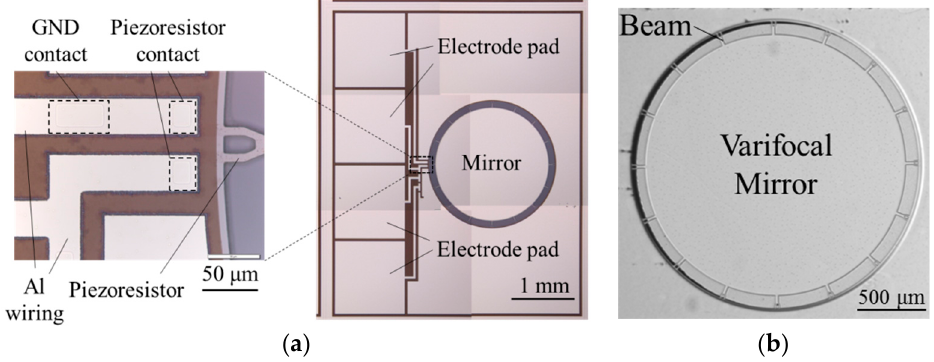
Figure 7. ( a ) Optical micrographs of the fabricated varifocal mirror and the piezoresistor with wiring. ( b ) The refraction surface of the varifocal mirror. GND: Ground.